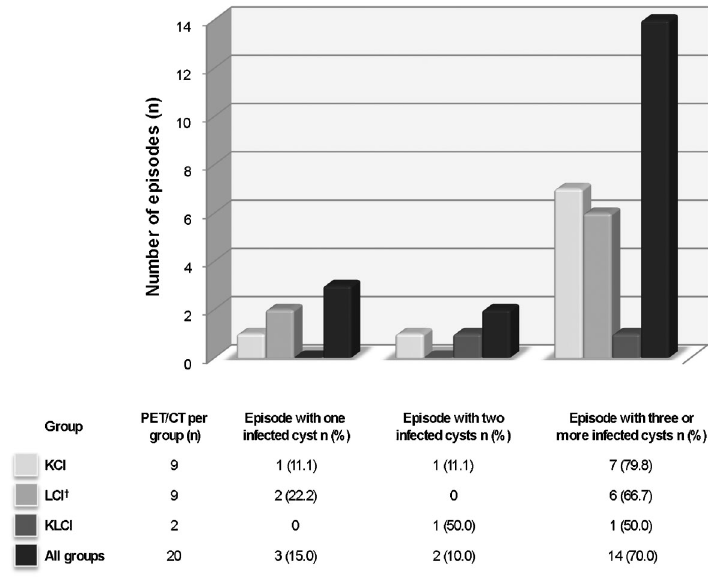
Figure 4. Number of infected cysts per episode evaluated by positron-emission tomography/ computed tomography (PET/CT). KCI: kidney cyst infection; LCI: liver cyst infection; KLCI: concomitant kidney and liver cyst infection. { : one ADPLD